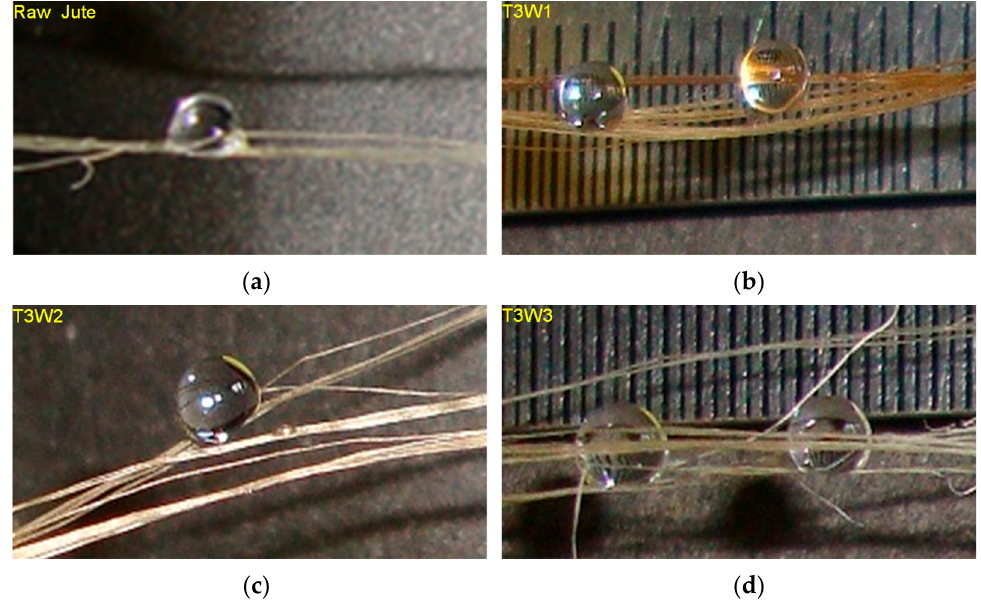
Figure 6. Contact angle measurements on ( a ) raw jute and treated fibers with different concentrations, ( b ) 10 wt.%, ( c ) 15 wt.%, and ( d ) 20 wt.%. ( b ) 10 wt.%, ( c ) 15 wt.%, and ( d ) 20